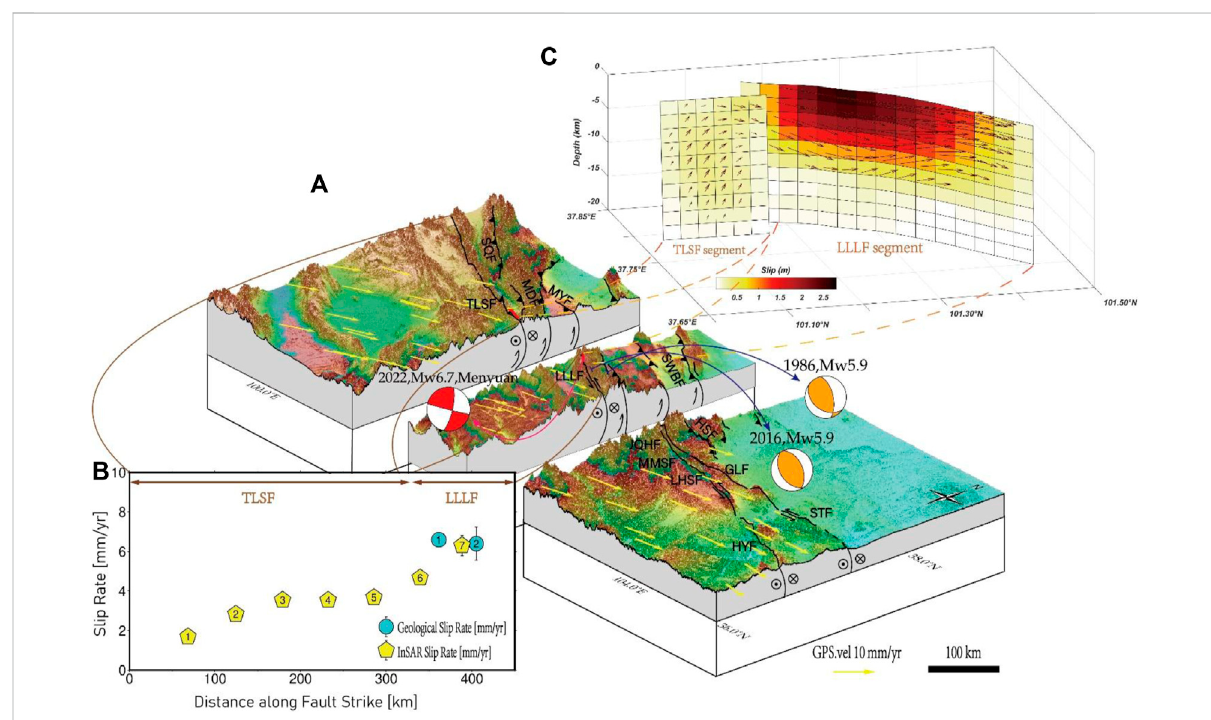
FIGURE 8 (A) Deformation partitioning model in the middle-western section of the northeast edge of the Tibetan Plateau. Yellow arrows show the GPS velocity mapfrom Wang and Shen, (2020).The red lines indicate therupture on TLSF and LLLFsegments for this earthquake. (B) Sliprate distribution along the TLSF and LLLF. Recent geological slip rates from Jiang et al. (2017) and Guo et al. (2017) are indicated in blue circles with No.1 and No.2, respectively; InSAR slip rates from Huang et al. (2022) are shown in yellow pentagon. (C) Three-dimensional fault-slip distribution of the 2022 Menyuan